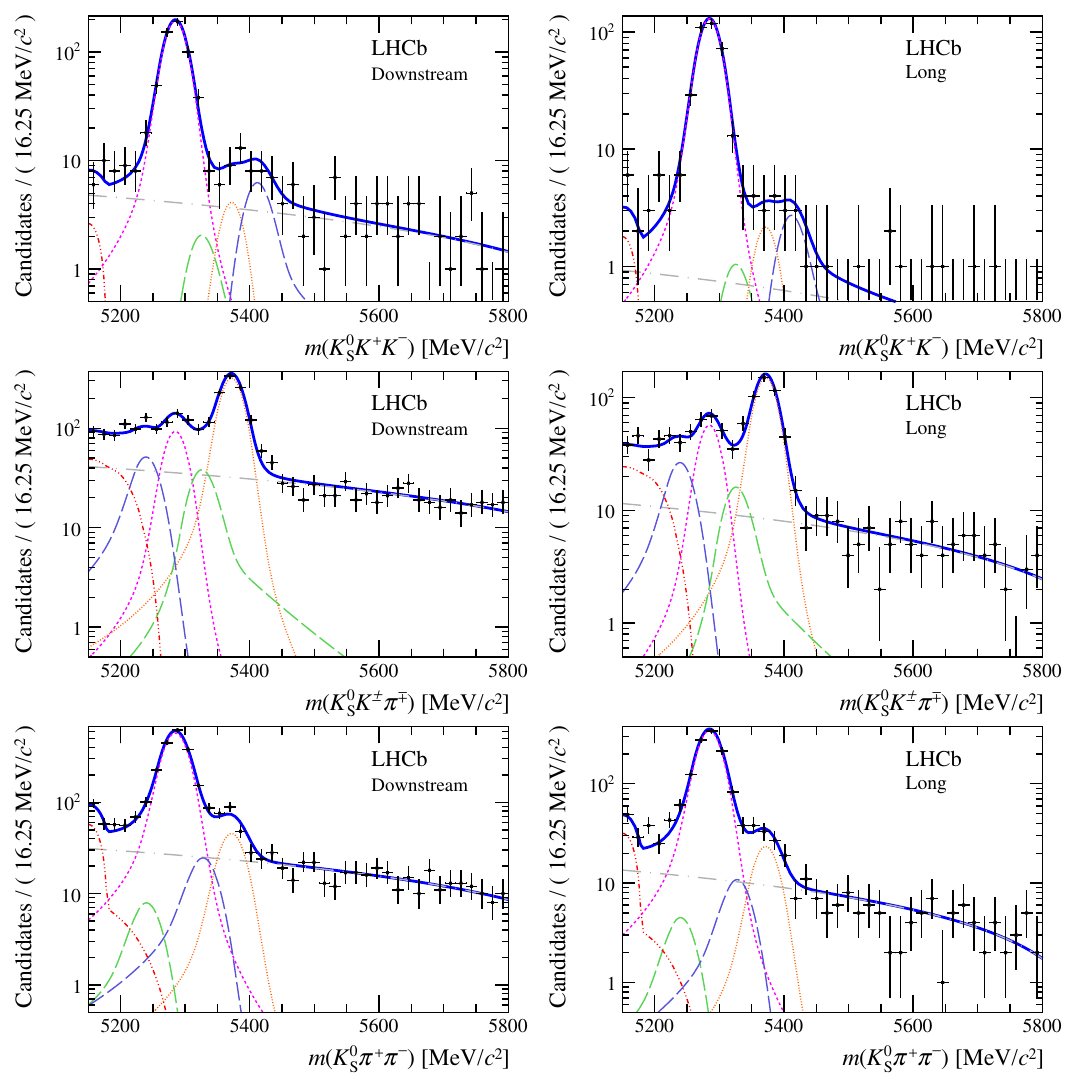
K (cid:6) (cid:25) (cid:7) and K 0 (cid:25) + (cid:25) (cid:0) K + K (cid:0) , K 0 S S S reconstruction categories. S